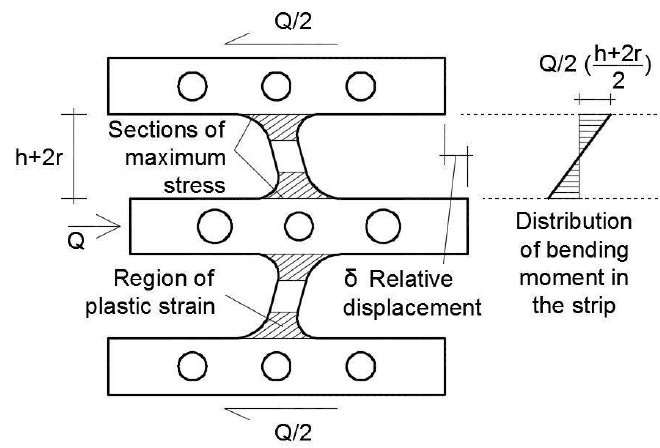
Figure 7. Relative displacement between interior and exterior flanges.